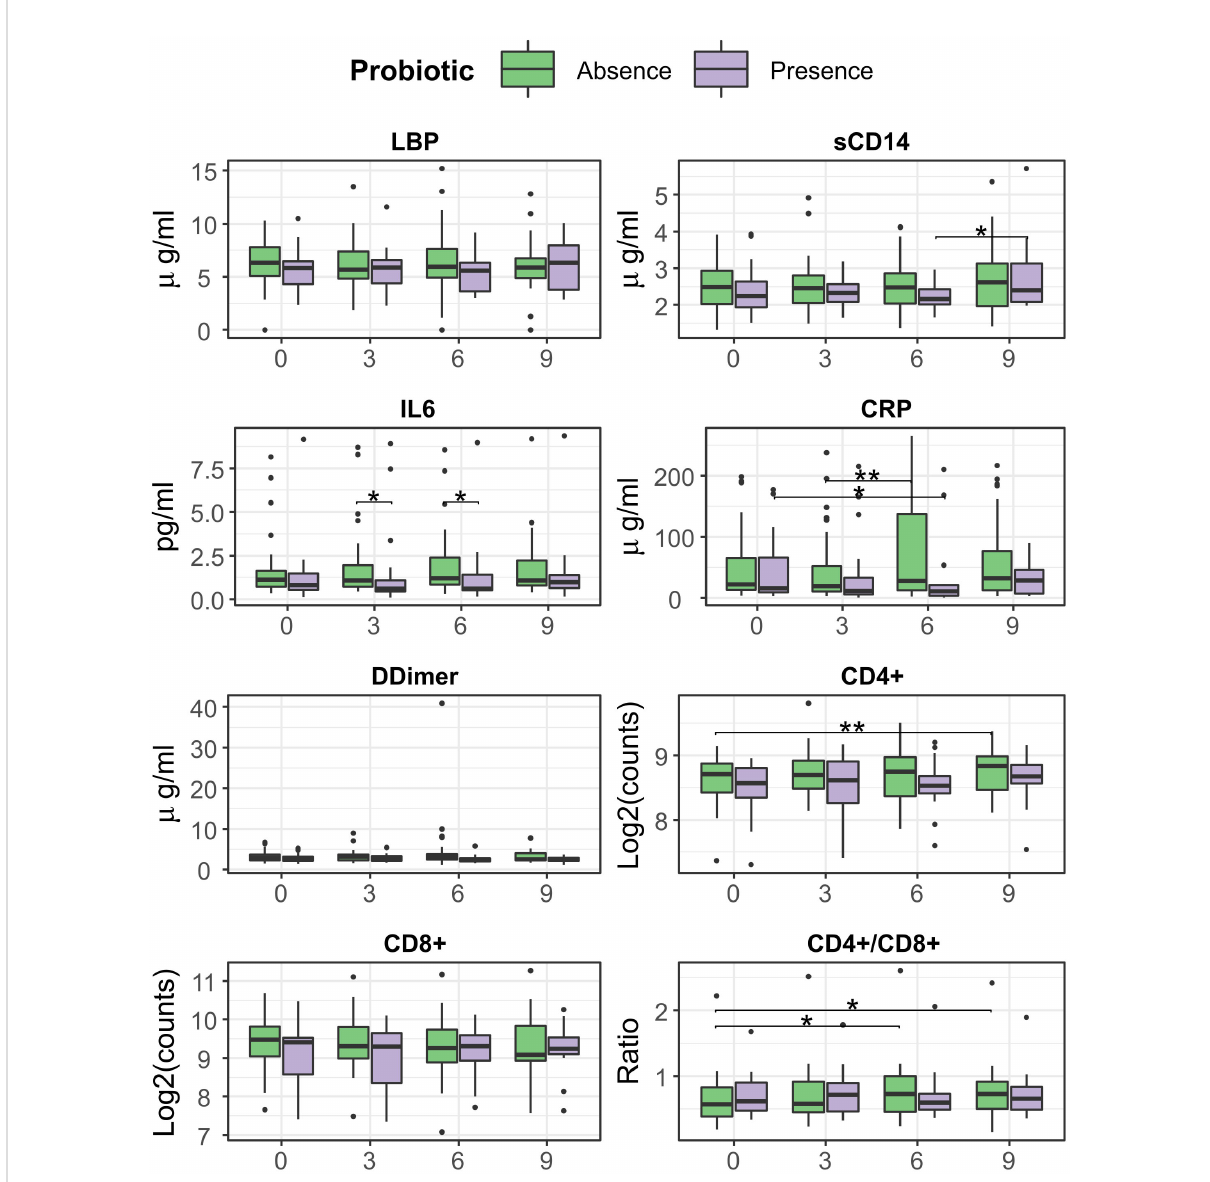
FIGURE 7 Evolution of T-cell counts, ratio, in fl ammation, and bacterial translocation markers between months 0 and 6, separated presence/absence of probiotic strains. Comparisons within group and between time points were performed by Wilcoxon test, in its paired form for longitudinal differences and unpaired for cross-group comparisons. Signi fi cance was coded as follows: *(p < 0.05), **(p <